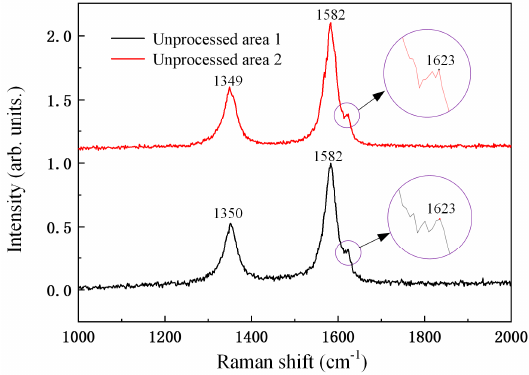
Figure 6. Raman spectra of two unprocessed areas of CNT film.